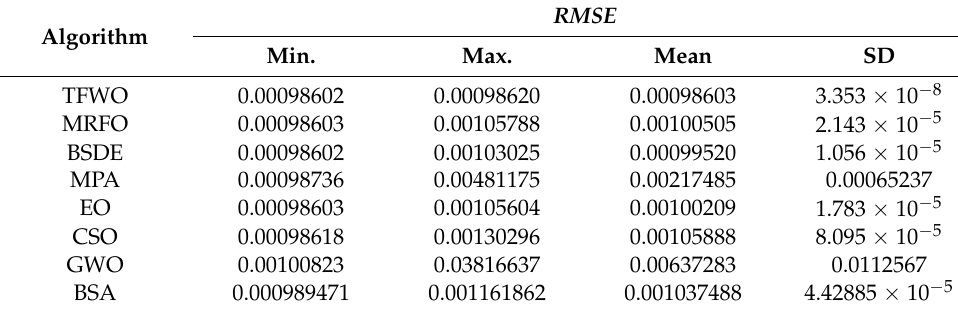
Table 4. Statistical analysis of RMSE for R.T.C. France